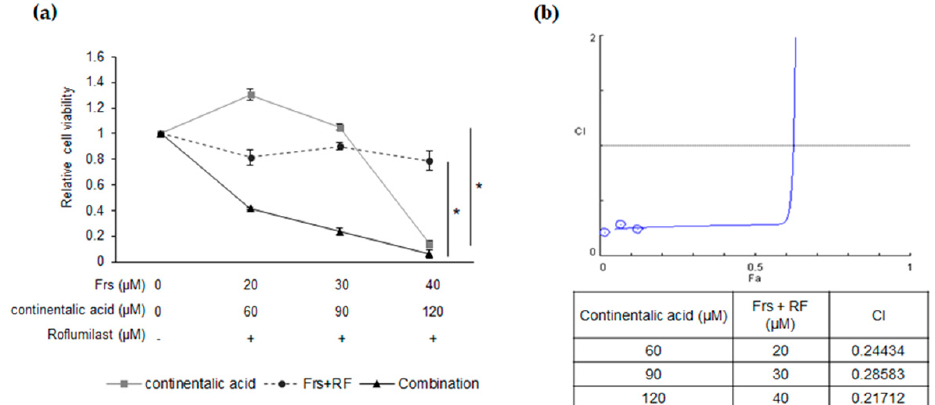
Figure 8. Continentalic acid therapeutically synergizes with forskolin/roflumilast to induce apop- tosis in DLBCL cells. ( a ) Ly1 was treated with forskolin (0 to 50 μ M) or continentalic acid (0 to